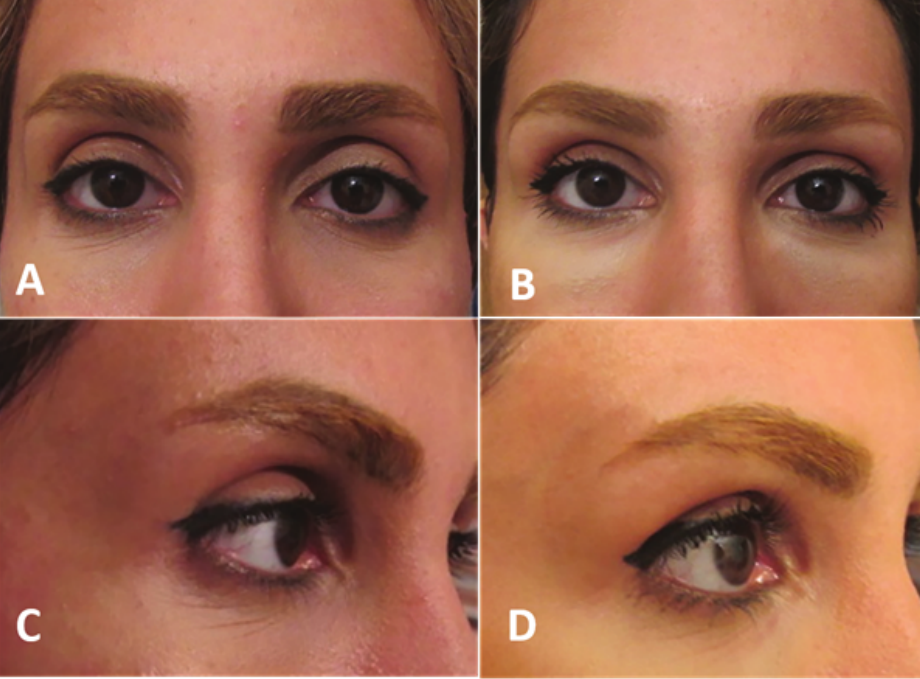
Figure 2. Before (A & C) and after (B & D) Hyaluronic acid gel (filler) injection under the lateral 2/3 of eyebrow. The injection yield to eyebrow projection especially in front view (B) and lift especially on lateral view (D).